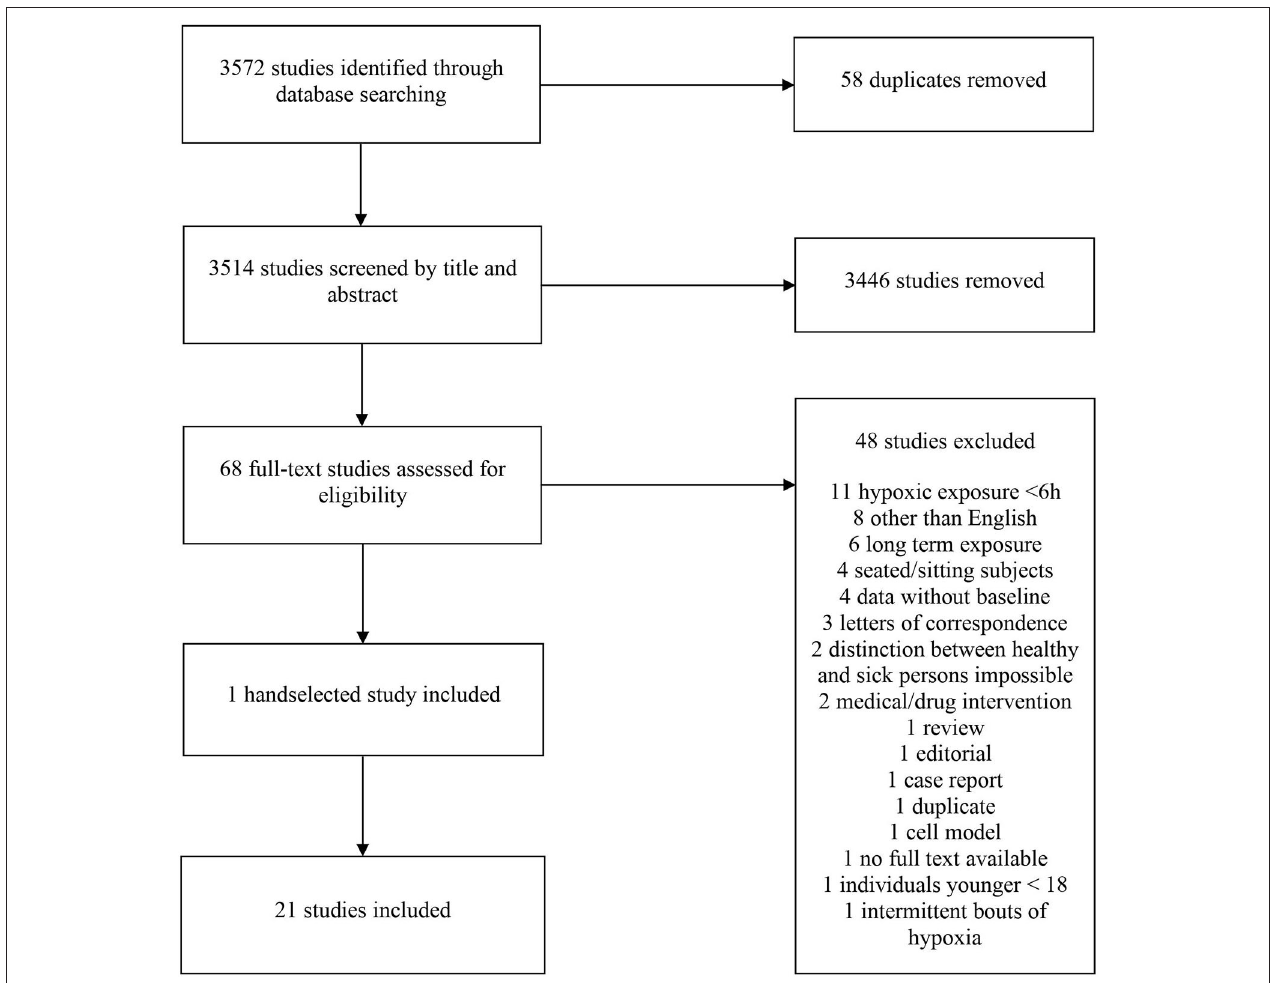
FIGURE 1 | PRISMA flow chart of the search